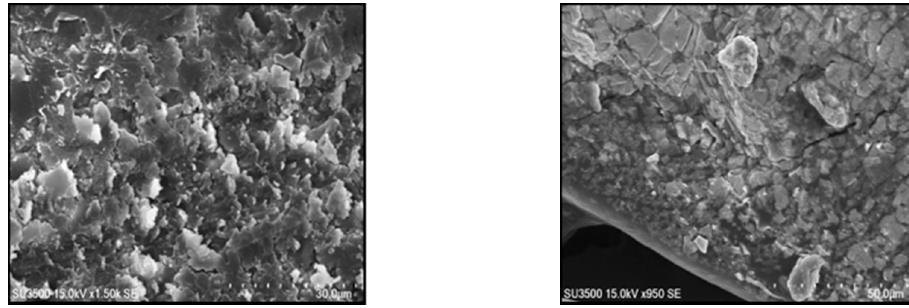
Figure 1. The scanning electron microscopy (SEM) view of the nano-adhesive under scanning electron microscope. electron